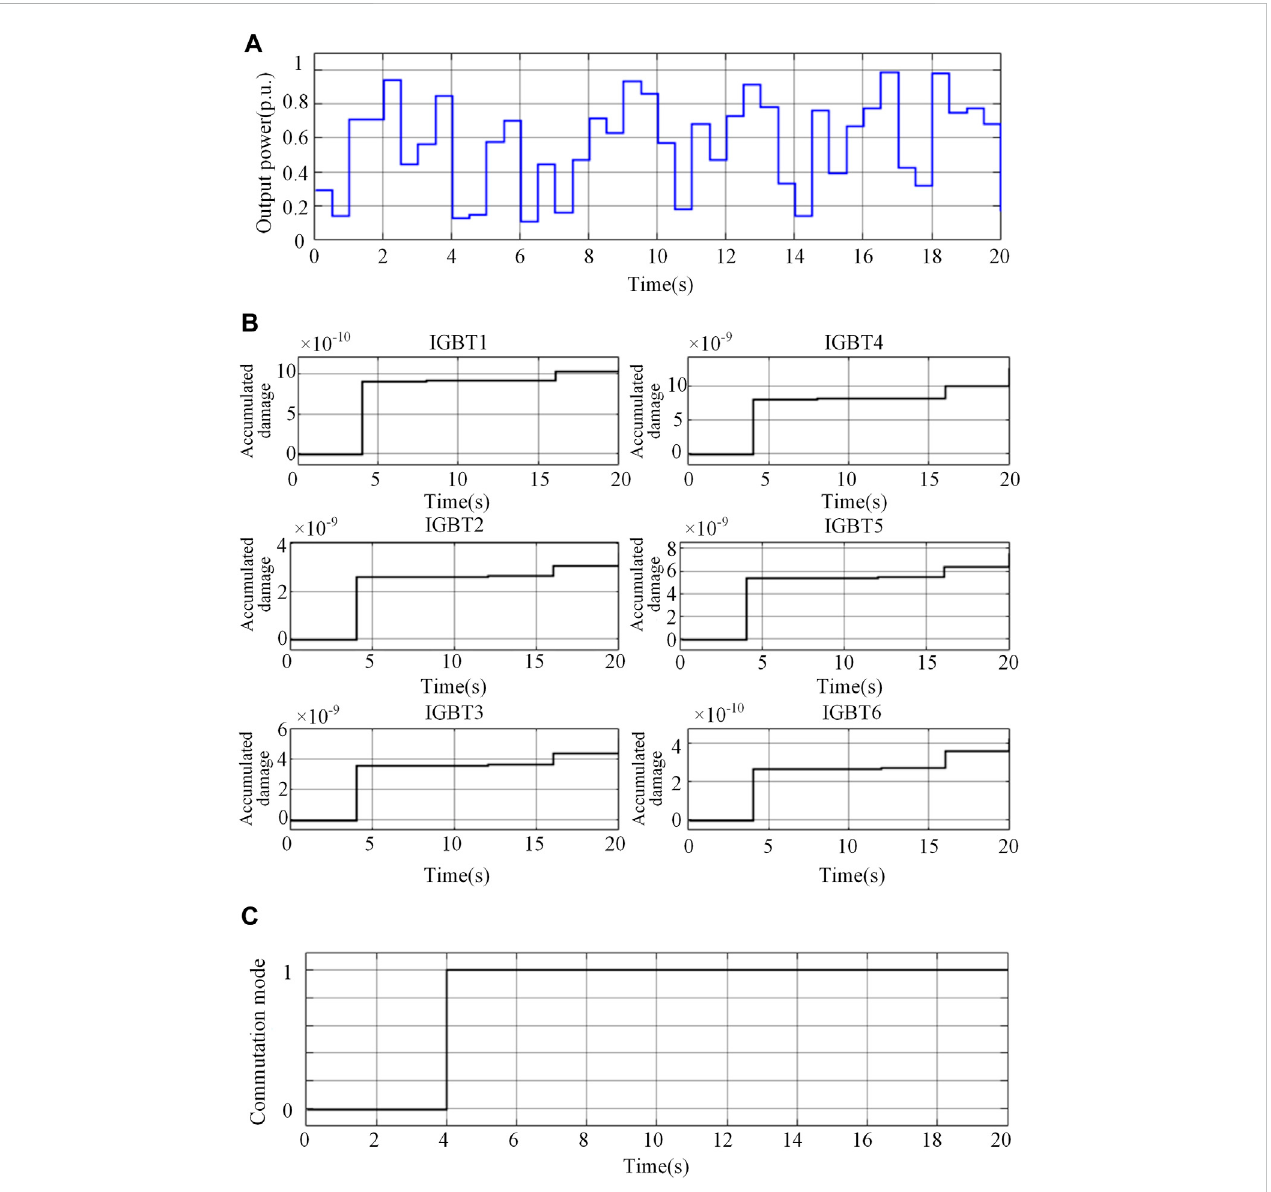
Simulation results for random load. (A) Mission pro fi le. (B) Accumulated damage of IGBT modules. (C) Selection of optimal commutation mode (0 represents passive commutation mode and 1 represents active commutation